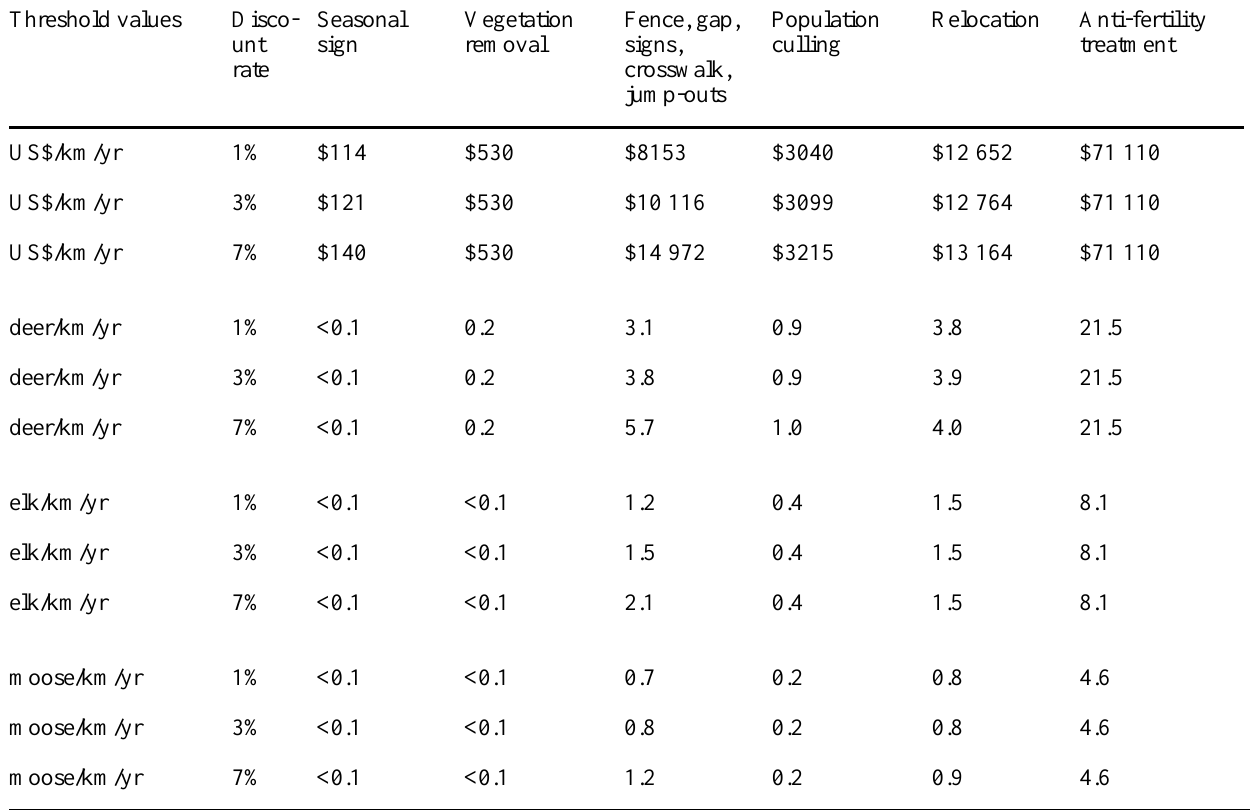
Table 3. Threshold values for individual mitigation measures that are estimated to reduce collisions with large ungulates by £ 50% (see Table 1 for estimated